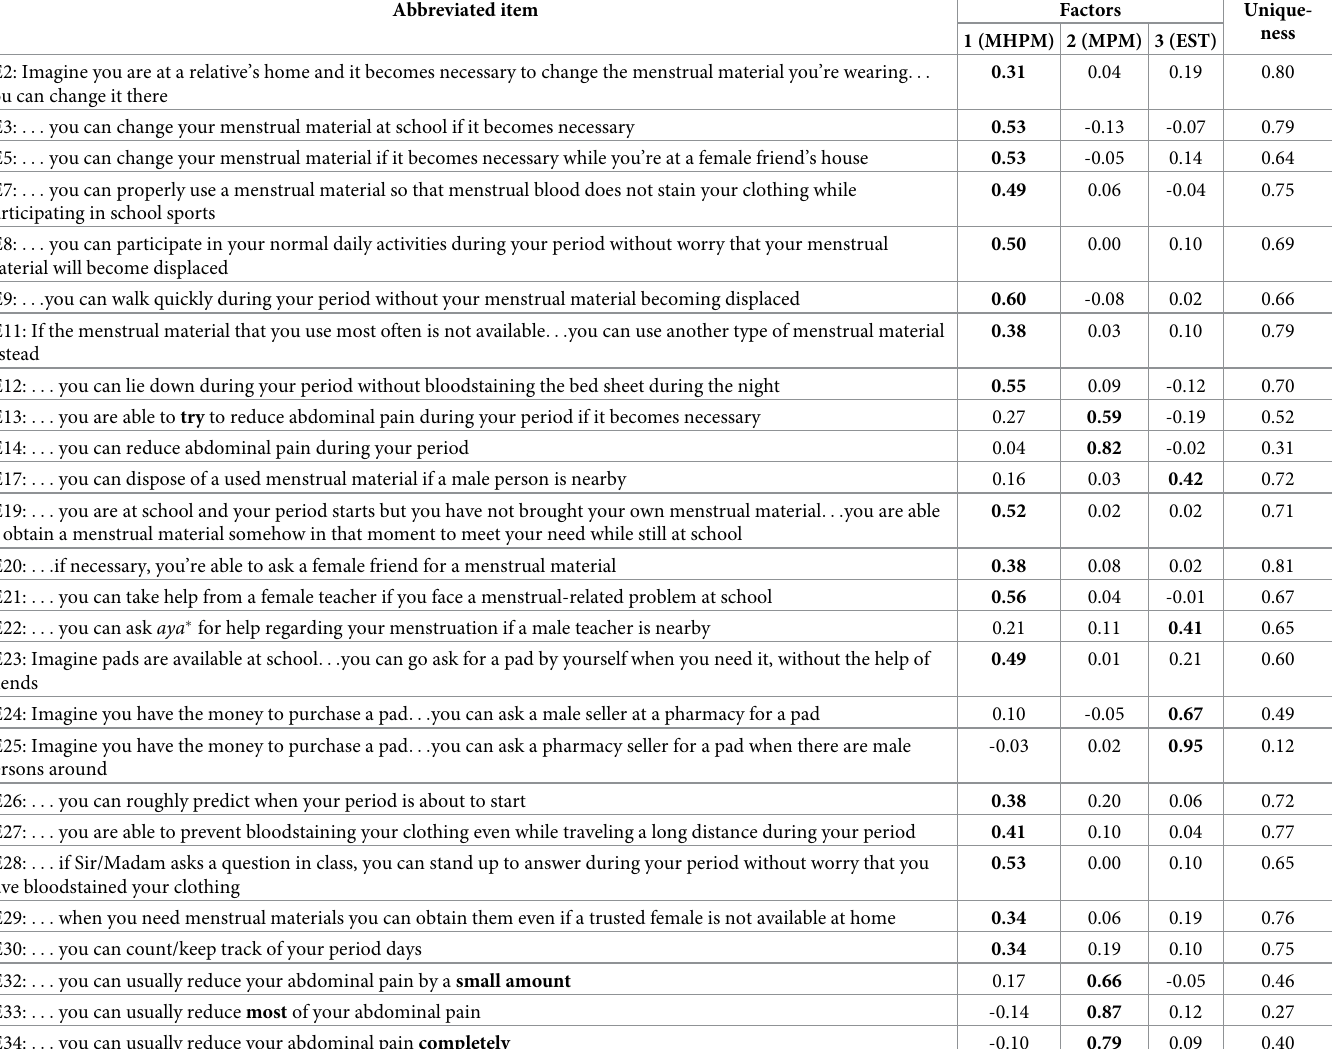
Table 2. Factor loadings based on exploratory factor analysis with oblimin oblique normalized rotation of 26 retained Self-Efficacy in Addressing Menstrual Needs items (n = 381). Abbreviated item Factors Unique-